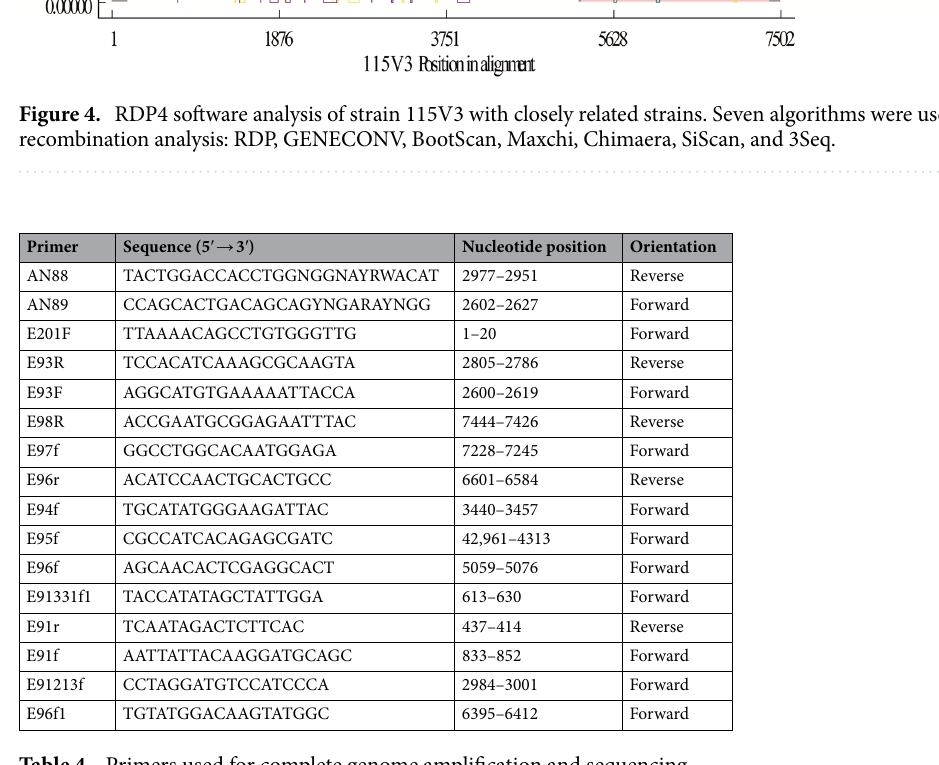
Table 4. Primers used for complete genome amplification and